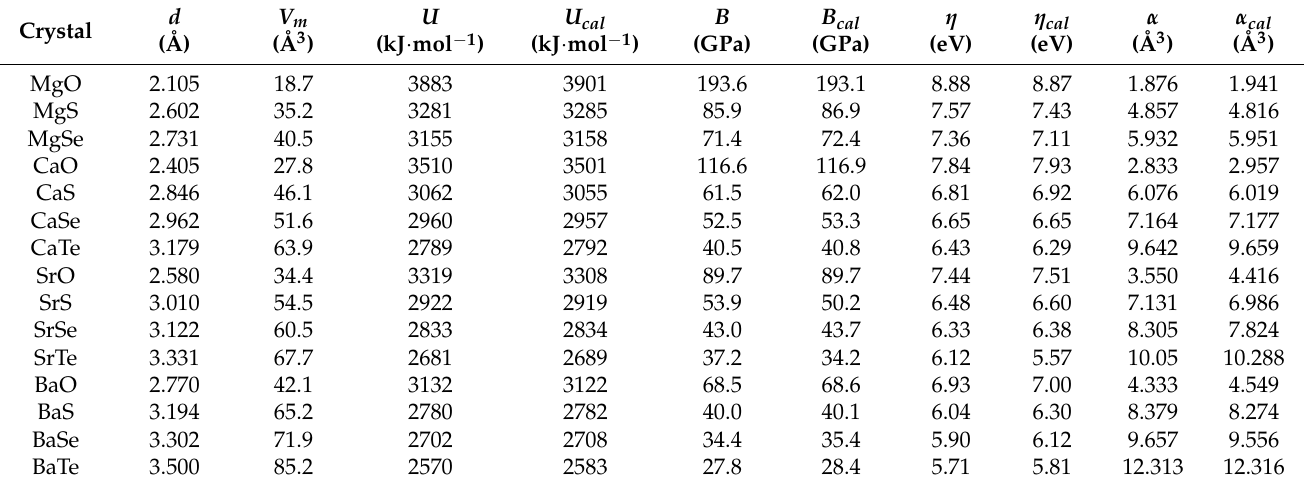
Table 2. Chemical bond length d , molar volume V m , lattice energy U , calculated lattice energy U cal , bulk modulus B and calculated bulk modulus B cal , chemical hardness η , calculated chemical hardness η cal , electronic polarizability α , calculated electronic polarizability α cal of rock salt crystals of group II–VI.